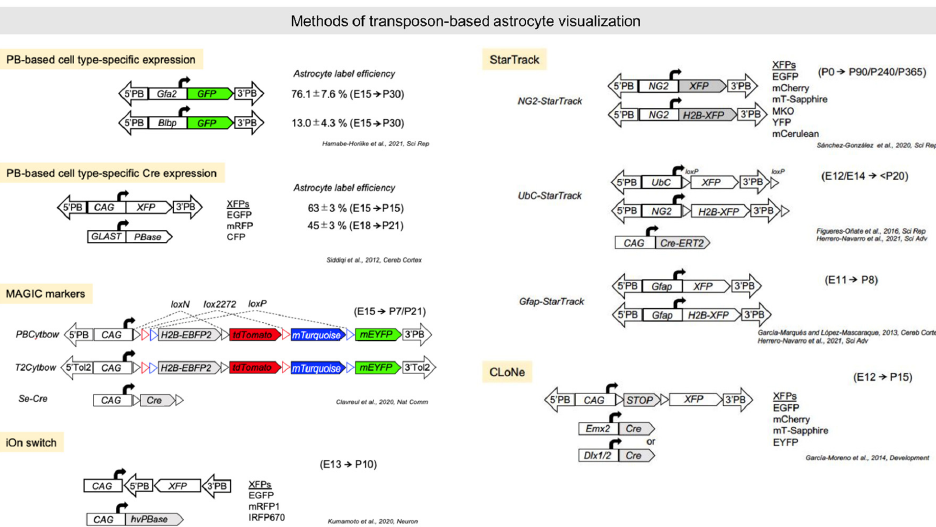
Figure 3. Transposon-based astrocyte visualization. Summary of genetic tools using piggyBac and Tol2 transposons. A summary of the plasmids and the timing of the experiments under investigation in the respective studies. 5 (cid:48) PB, 5 (cid:48) piggyBac terminal repeat; 3 (cid:48) PB, 3 (cid:48) piggyBac terminal repeat; 5 (cid:48) Tol2, 5 (cid:48) Tol2 terminal repeat; 3 (cid:48) Tol2, 3 (cid:48) Tol2 terminal repeat. XFPs denote each fluorescent protein included in the